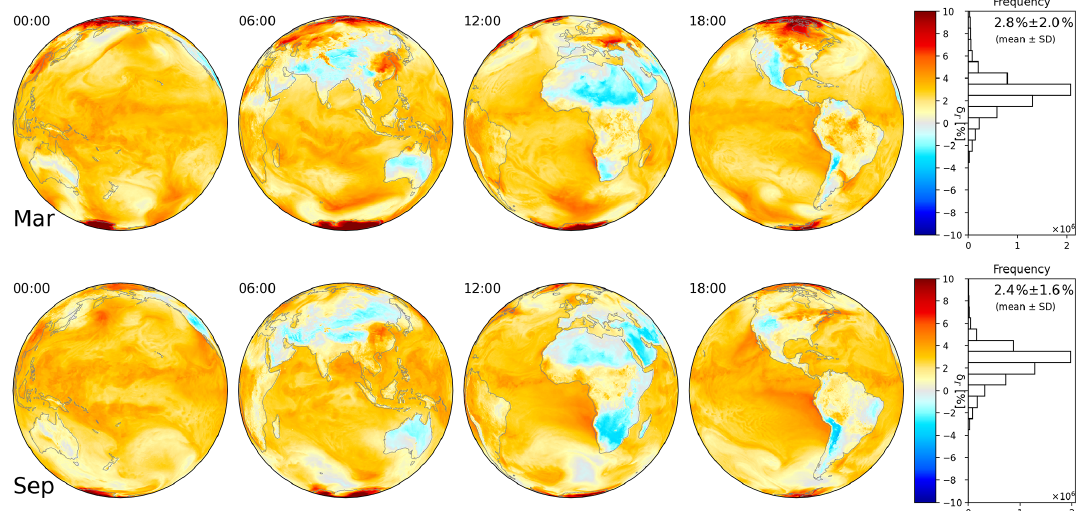
Figure C1. Deviation δ (cid:48) according to Eq. (19) for ERA5 at 00:00, 06:00, 12:00, and 18:00UTC on 18 March (top) and 18 September (bottom) 2018. The projection focuses on daytime for each time step. On the right, the frequency distribution and mean and SD are given for all hourly outputs of the respective day.